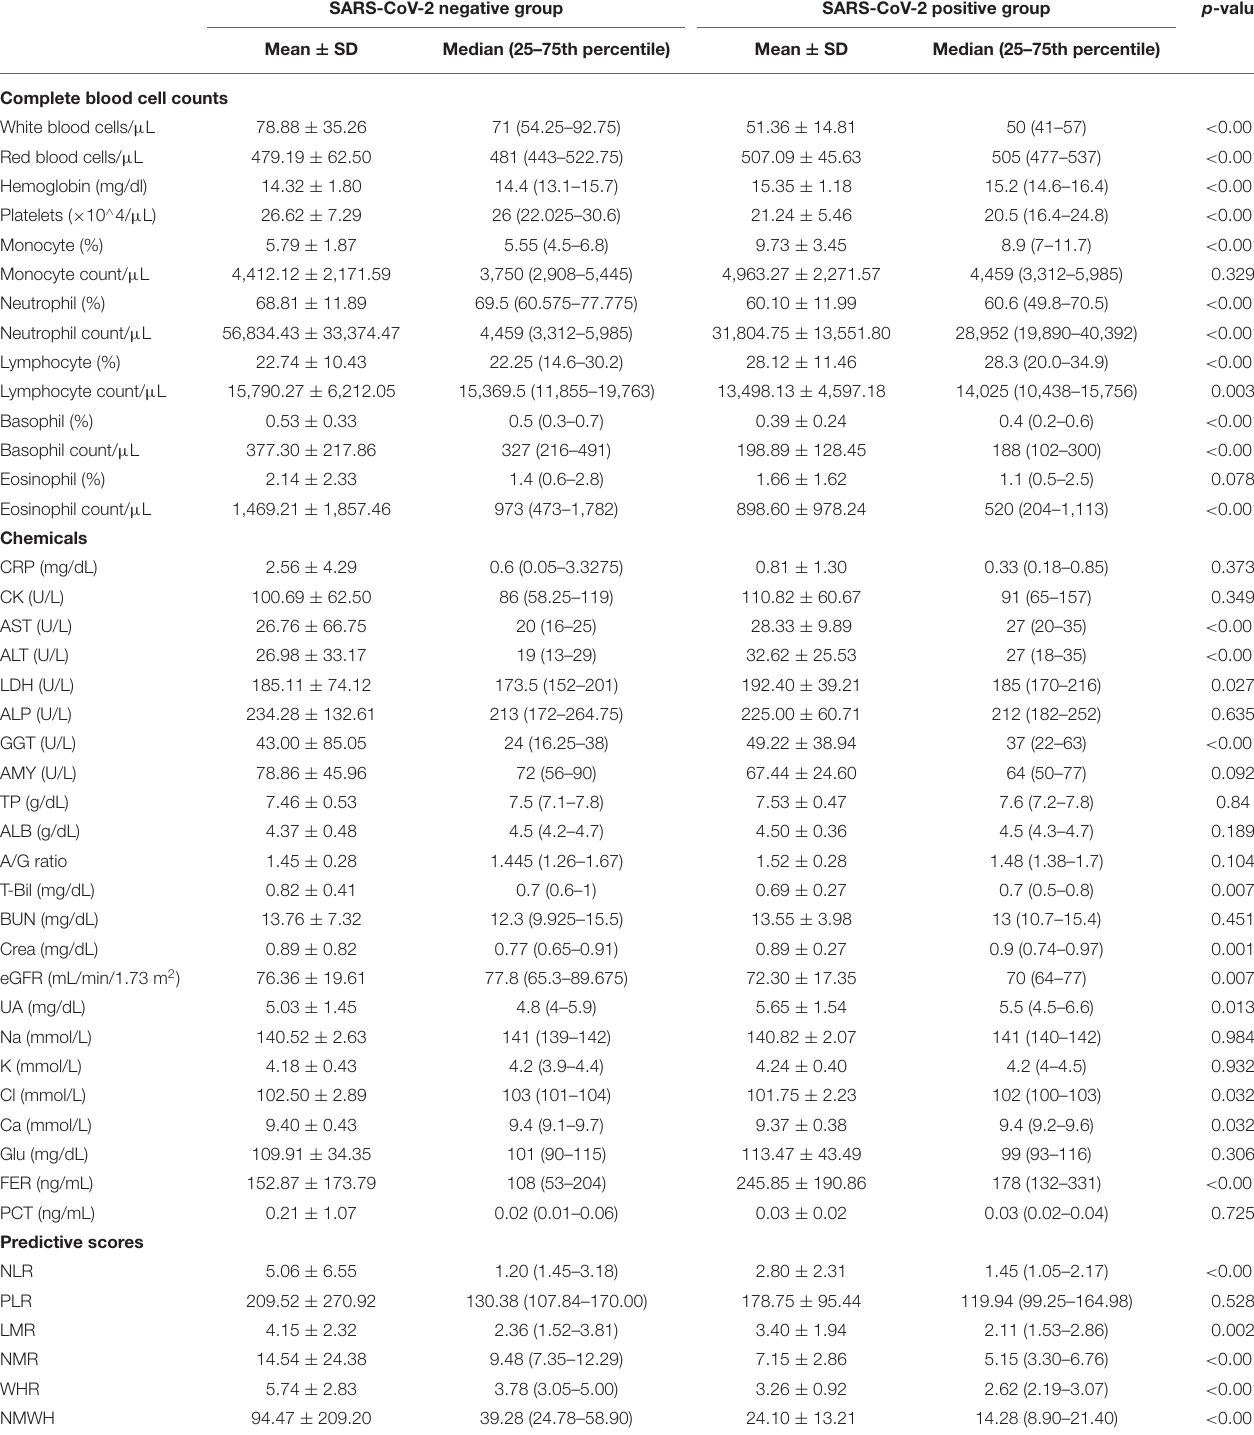
TABLE 2 | Patient blood test results, biochemical parameters, and predictive scores. SARS-CoV-2 negative group SARS-CoV-2 positive group p -value Mean ±